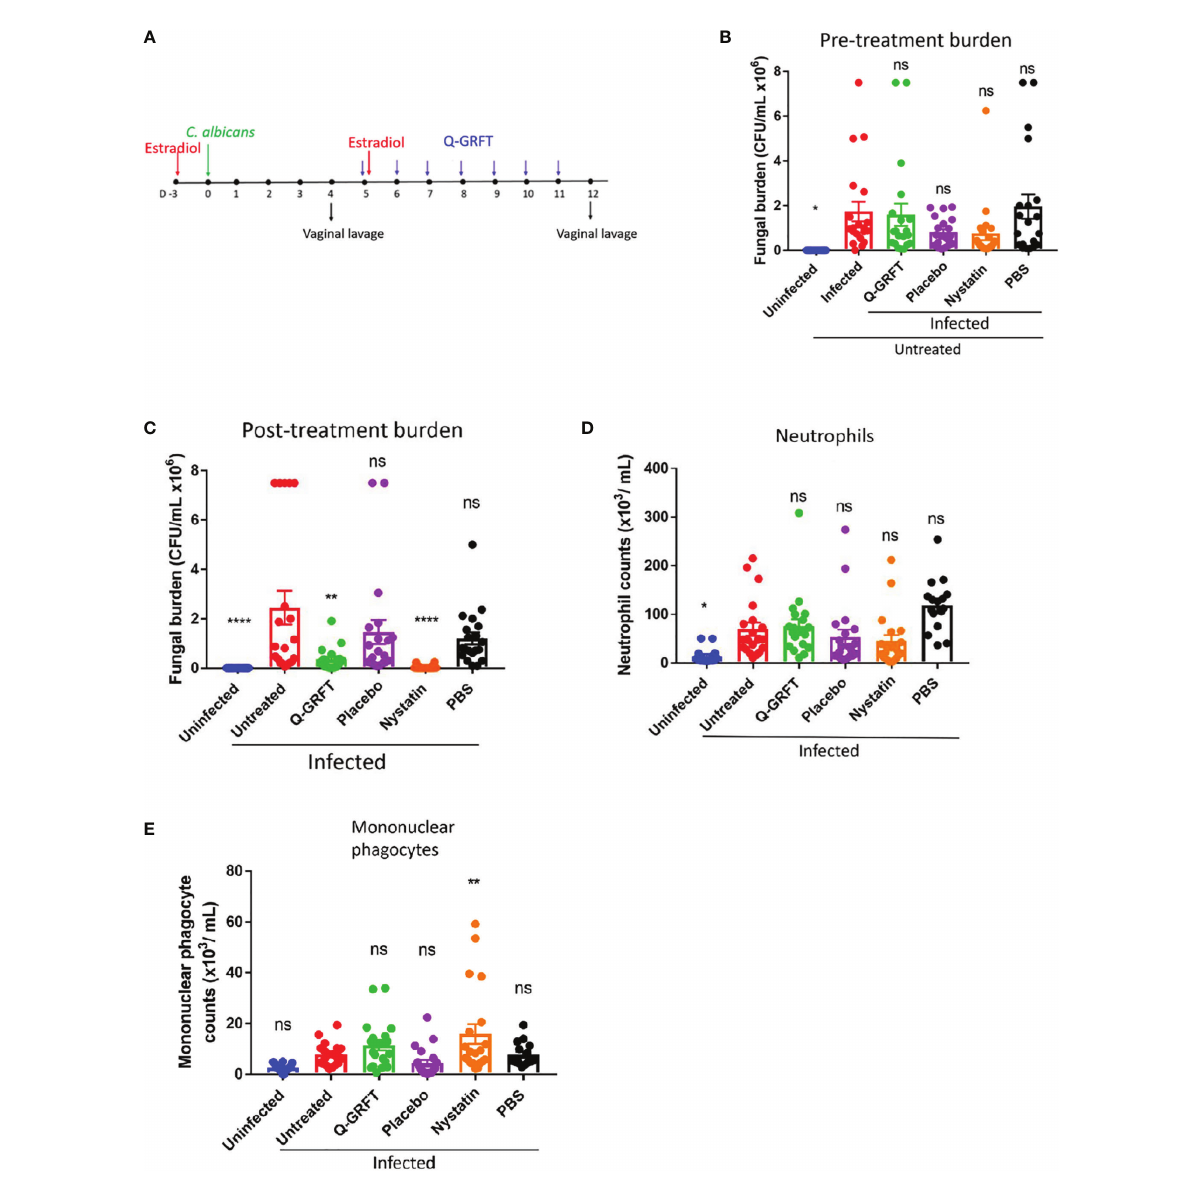
FIGURE 2 Ef fi cacy of Q-GRFT in a murine model of vaginal candidiasis. (A) Experimental scheme. CBA/J mice were estradiol-treated, followed by vaginal inoculation with 20 µL of C. albicans blastospores at a cell concentration of 1.0 X 10 8 CFU/mL 3 days later. Treatment with either Q-GRFT, nystatin, placebo, or PBS by vaginal instillation was started on Day 5 following inoculation and continued twice daily for a total of 7 days, respectively. Vaginal lavage was performed at Day 4 and Day 12 to establish pre-treatment and post-treatment fungal burden, respectively. (B) Day 4 (pre-treatment) Vaginal fungal burden (CFU/mL), and (C) Day 12 (post-treatment) burden. (D) Neutrophil and (E) mononuclear phagocyte cell populations in the vaginal lavage following infection and respective treatments, as determined using Flow cytometry. Each dot represents one mouse, N=20 mice per group. Experiments were performed at least 2-3 times and representative data from 2 experiments, Mean ± SEM is shown. One-way ANOVA was used for statistical analyses and P ≤ 0.05 was considered signi fi cant. For normality testing, Dunnet ’ s test (B) , and Tukey ’ s test (C-E) were performed for respective datasets. For all datasets, all groups were compared to infected untreated controls. *p=or < 0.05 , ** p=or < 0.01 , ****p =or < 0.0001 and ns=not signi fi